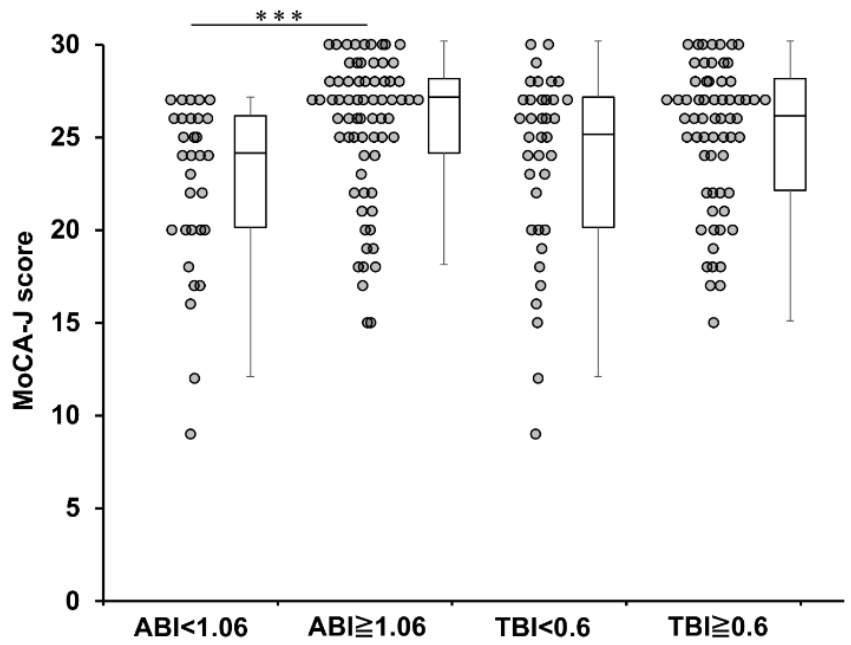
Figure 1. Comparison of MoCA-J score between the two groups divided by ABI and TBI cutoff values. MoCA-J: the Japanese version of the Montreal Cognitive Assessment, ABI: ankle brachial index, TBI: toe brachial pressure index, *** p < 0.001. Table 2. Comparison of MoCA-J scores in two groups divided by (a) ABI and (b) TBI cutoff values.